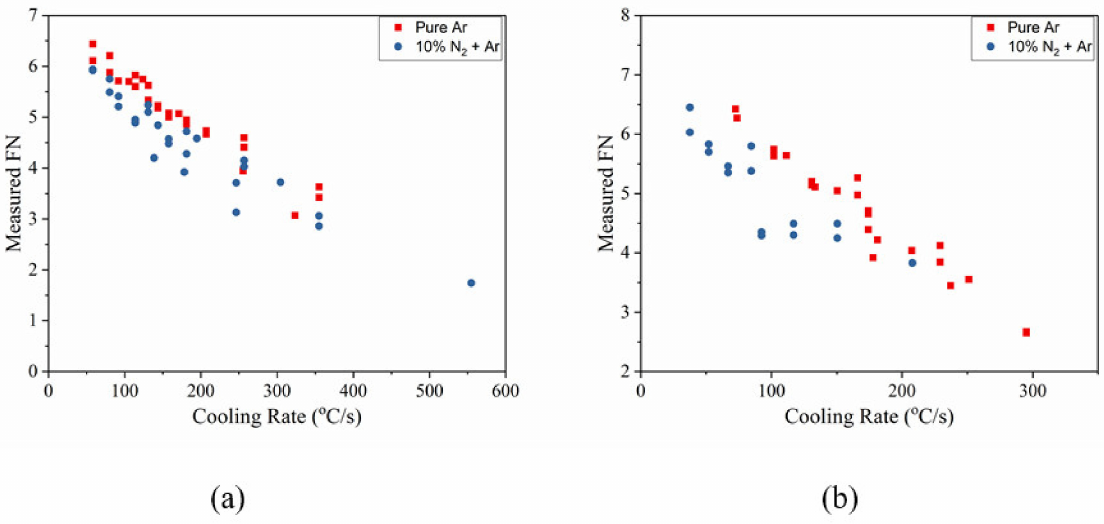
Figure 12. The ferrite number measured using a FeritScope of the welds made on ( a ) 0.7 mm thick sheets; ( b ) 0.9 mm thick sheets.